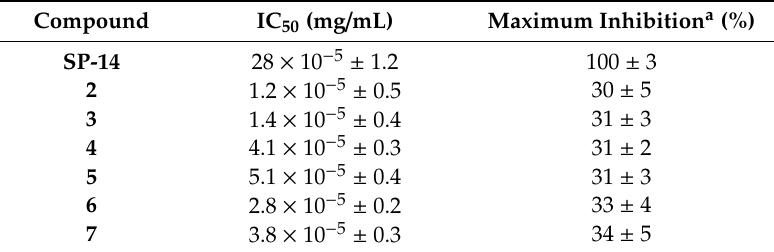
Figure 2. ( a,b ). Concentration-response curves of SP14 CPS fragments on the inhibition of SP-14 CPS binding to an anti-SP-14 rabbit polyclonal antibody (competitive ELISA). Table 1. Results of the competitive ELISA assay.